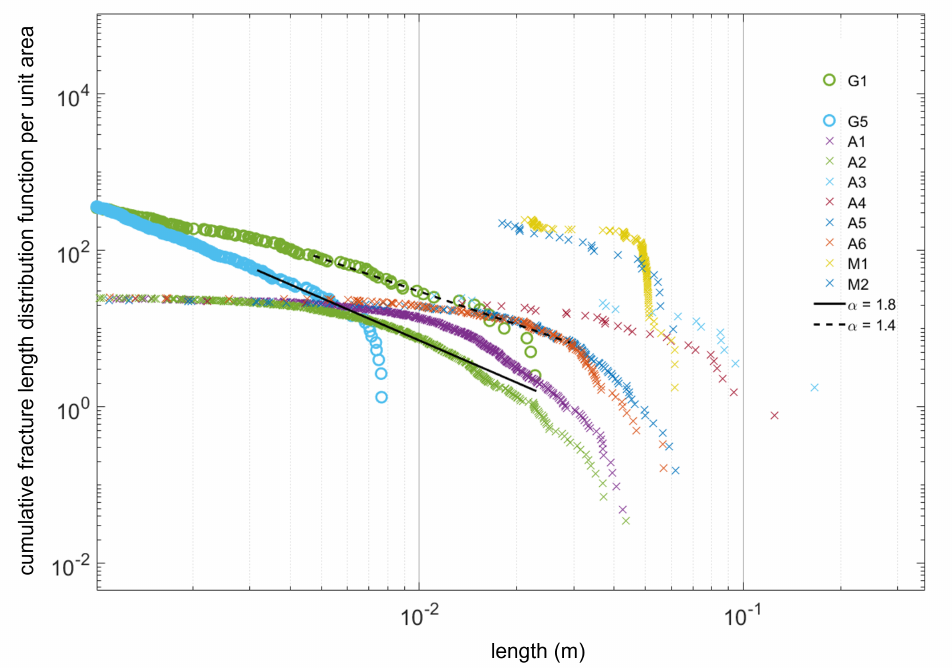
Figure 9. Fracture length distribution for shale samples G2 and G5; rock analog samples A1, A2, A3, A4, A5, and A6; and microfluidic models M1 and